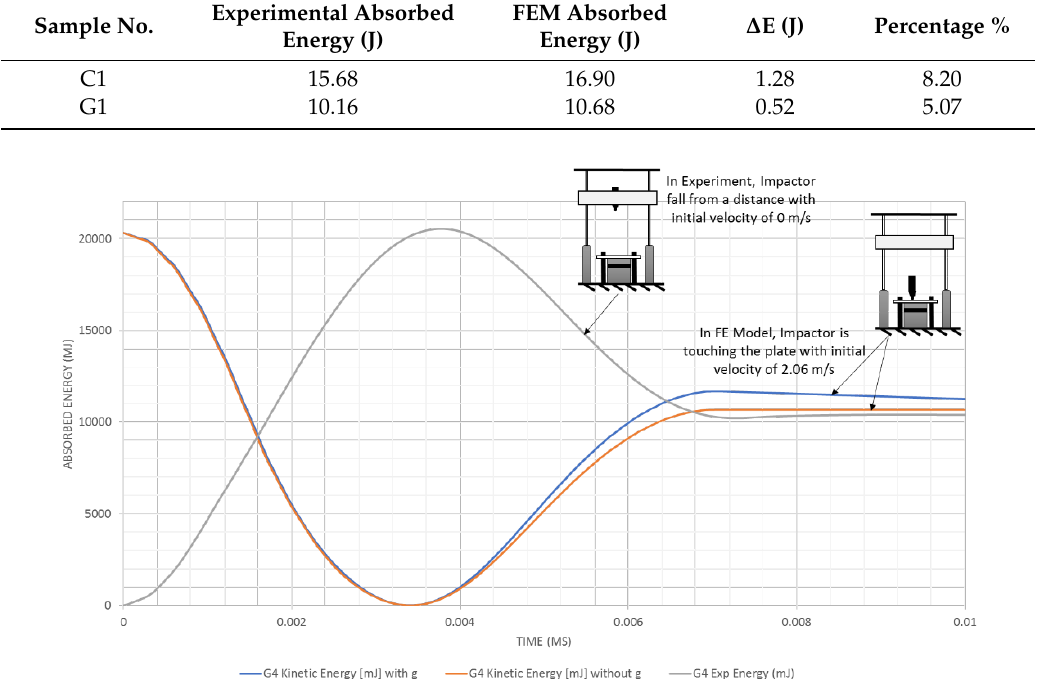
Figure 13. Energy-time curves comparison of the experimental test data and finite element analysis (FEA) data of the G4 fiberglass plate impacted with 20 J.